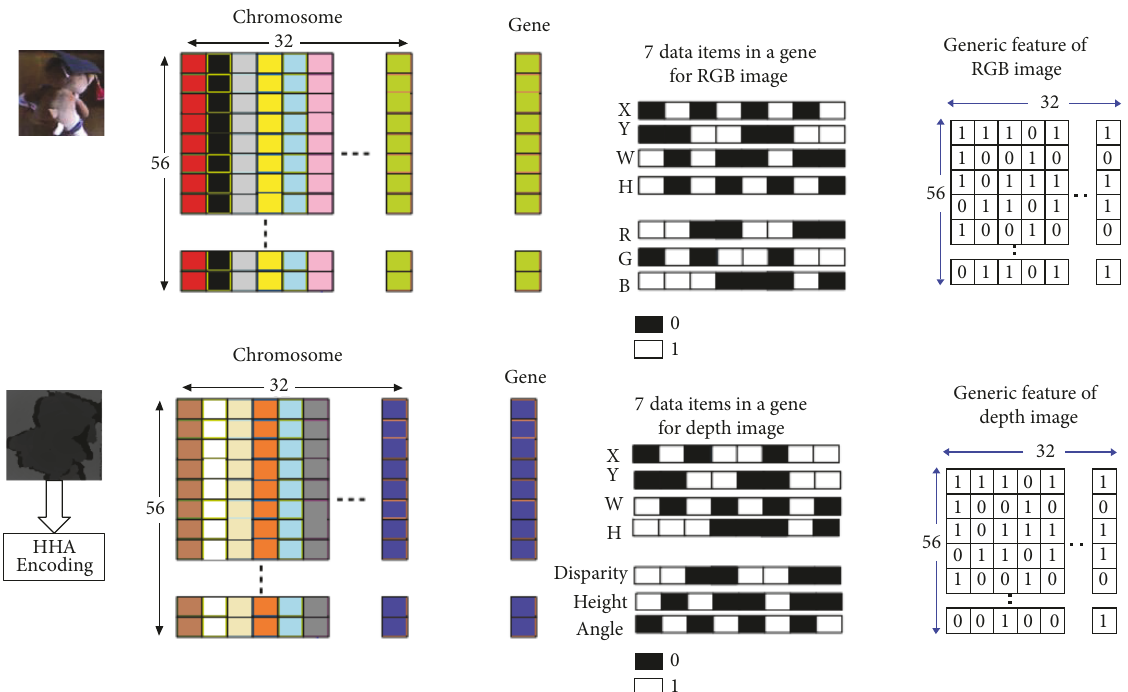
Figure 1: Individual representations in RGB and depth modality in GA.